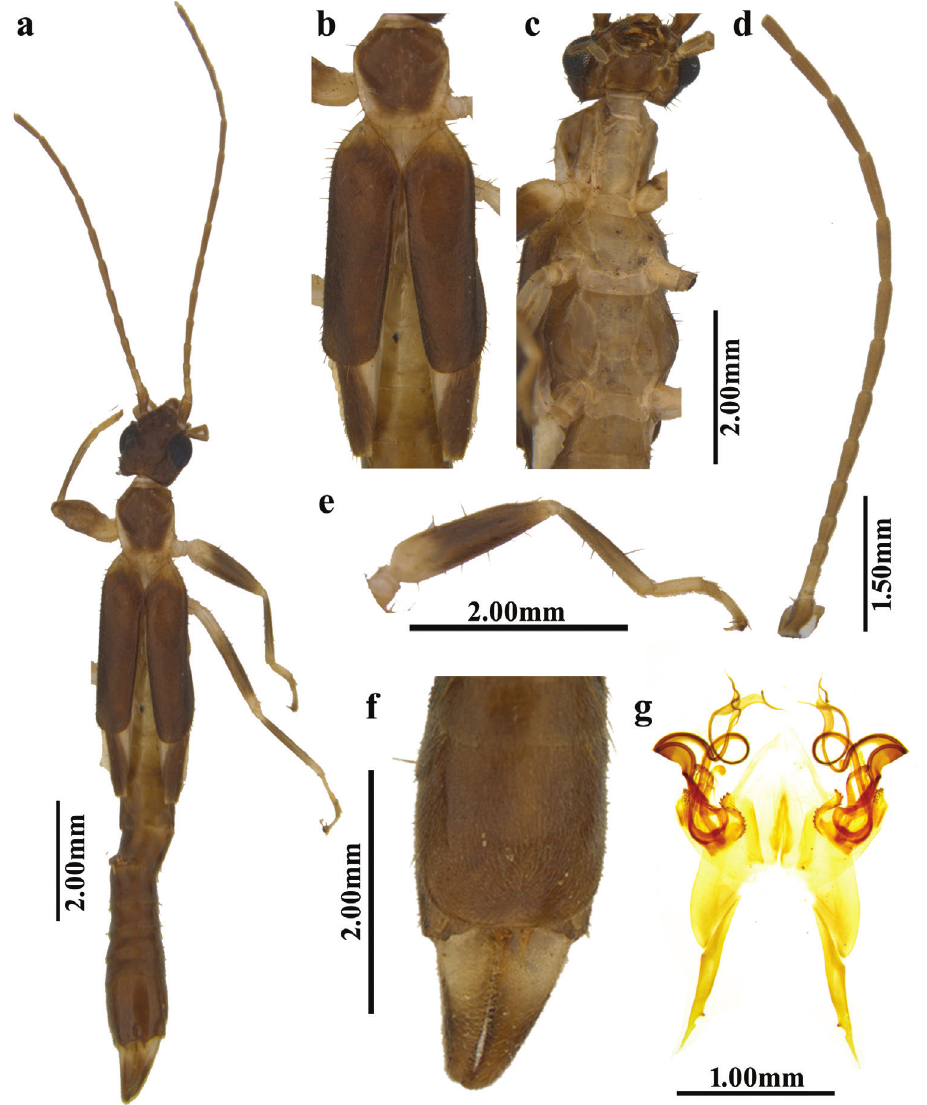
Figure 1. Diplatys sahyadriensis sp. nov. (male holotype) a habitus b pronotum, tegmina and wings c thoracic sterna d left antenna e right foreleg f penultimate sternite and forceps g